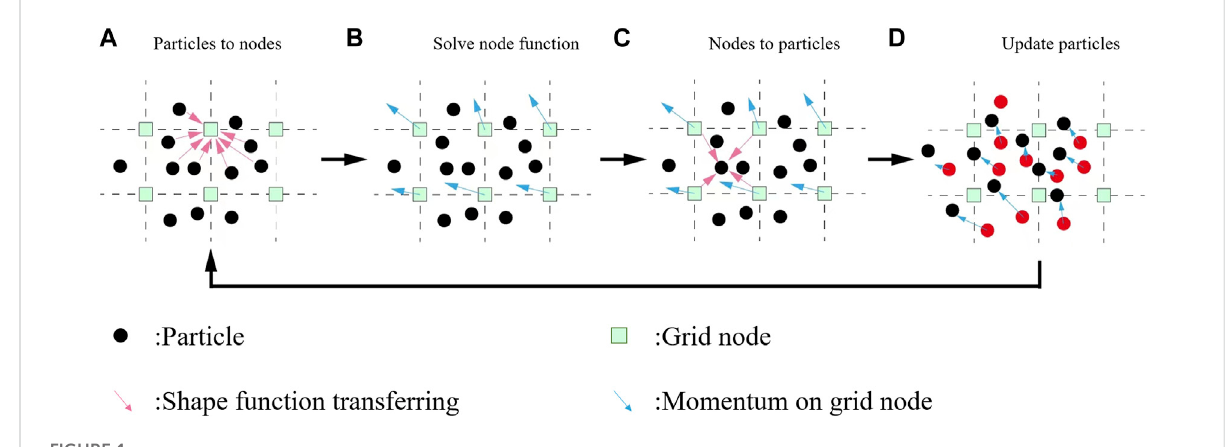
FIGURE 1 Computational cycle for the standard Material Point Method. (A) Map information from particles to grid nodes. (B) Solve node function. (C) Remap information to particles. (D) Update velocity and position of